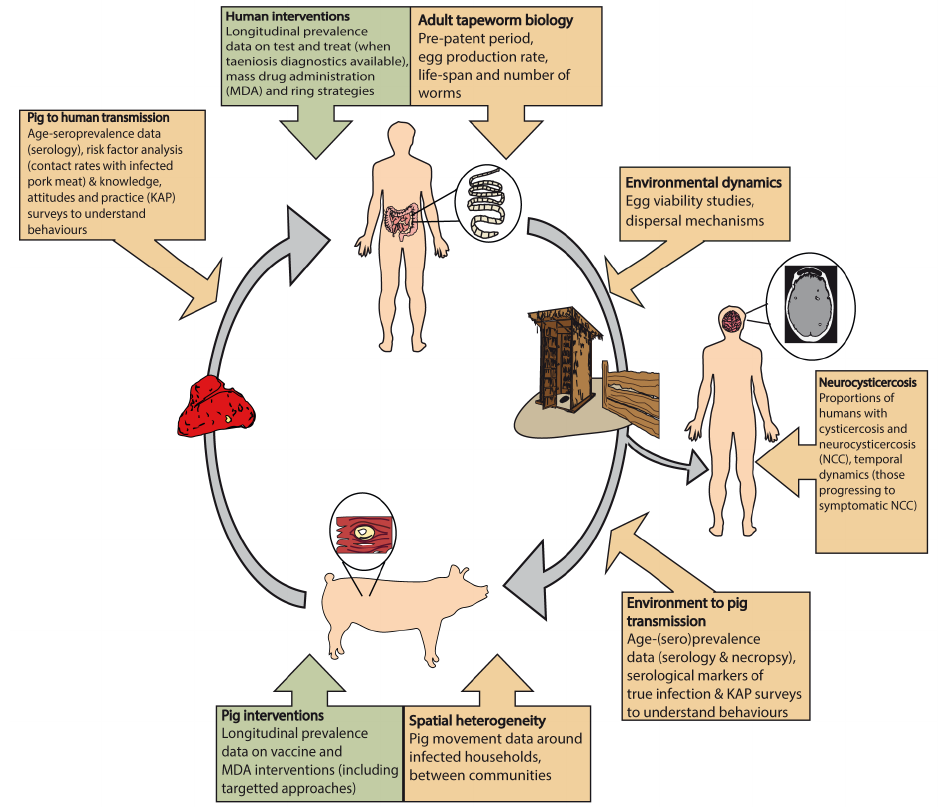
Figure 4. Lifecycle of Taenia solium . The lifecycle indicates, at each stage, key research gaps and data needs important for epidemiological modelling. This figure has been reproduced under the Creative Commons Attribution 4.0 International Licence (CC BY 4.0) from Dixon et al . 32 . NCC: